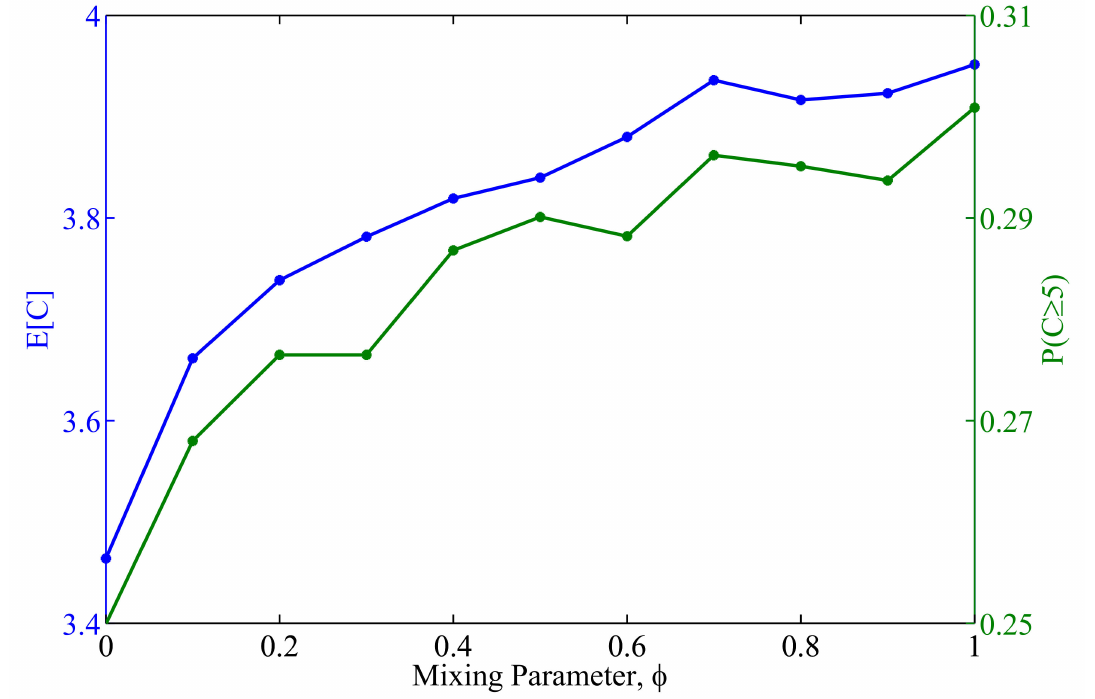
Figure 3. The average number of infected cases (E[ C ], left , blue ) and the probability of a large outbreak (P[ C ≥ 5], right , green ) as the mixing parameter changed in a population with two subgroups each of 500 individuals. The mixing parameter was the ratio of the probability of infecting a susceptible in the other subgroup to the probability of infecting a susceptible in the same subgroup. There were replications and the standard error was less than 0.04 for E[ C ] and 0.02 for P[ C ≥